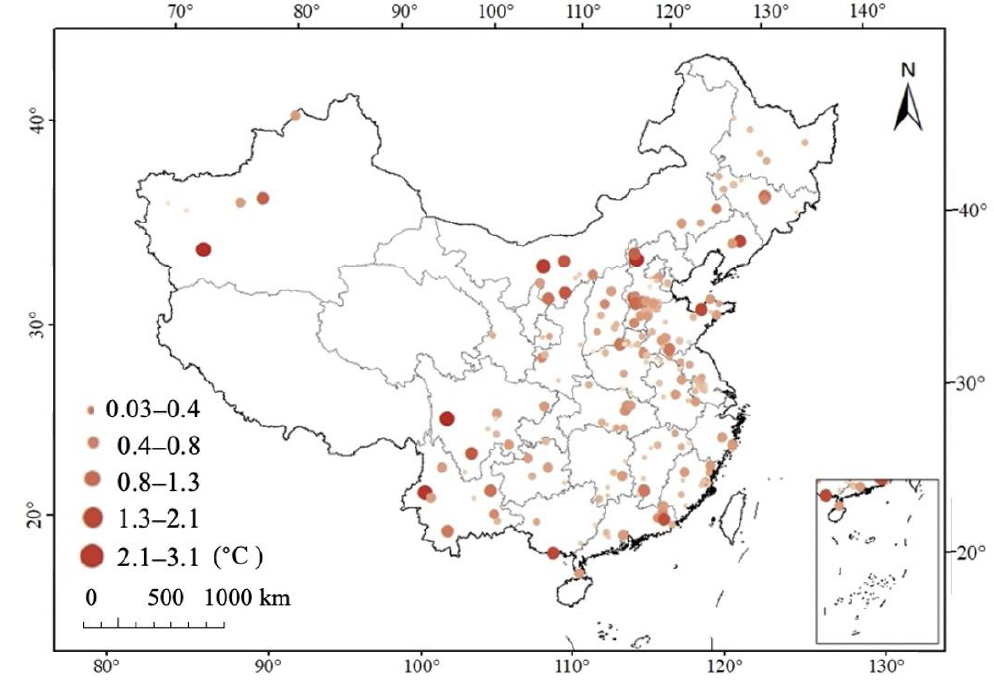
Figure 2. Annual mean UHII for 61 prefecture-level cities and 136 county-level cities in 2019.